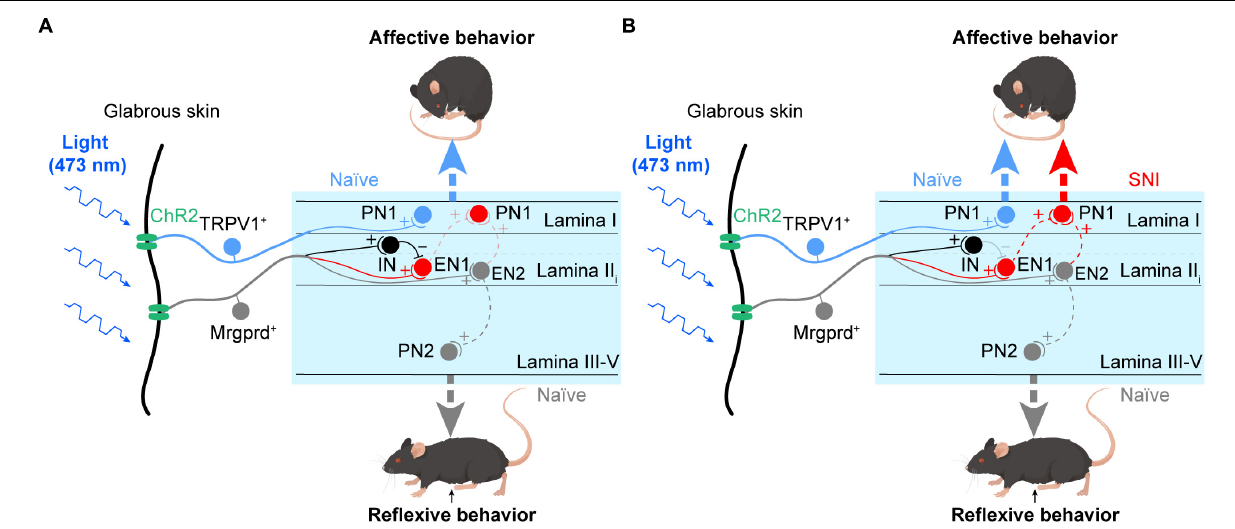
FIGURE 8 | Parallel spinal pathways for transmitting reflexive and affective dimensions of nocifensive behaviors evoked by selective activation of the Mrgprd + and TRPV1 + subsets of nociceptors. (A) Under normal conditions, activation of Mrgprd + afferents elicits reflexive behaviors, which are possibly transmitted through the deep spinal pathway (gray, EN2-PN2). In contrast, activation of TRPV1 + afferents can elicit affective behaviors, which are possibly transmitted through the superficial spinal pathway (blue, TRPV1-PN1). (B) Under neuropathic pain conditions, activation of Mrgprd + afferents can evoke affective behaviors by opening the superficial spinal pathway (red). (PN1: projection neurons in superficial layer, PN2: projection neurons in deeper layer, IN: inhibitory neurons, EN1: excitatory neurons that are gated by IN and receive excitatory inputs from Mrgprd + nociceptors, EN2: excitatory neurons that are excited by Mrgprd + nociceptors). We hypothesize that PN1 receives excitatory inputs from EN1 and EN2. The EN1-PN1 pathway which is “gated” via feed-forward activation of IN and the EN2-PN1 pathway which is “gated” via electric filtering of potassium currents transmit affective behaviors. After nerve injury, disinhibition of EN1 and/or central sensitization of PN1 cause “gate-opening” of superficial spinal pathway, leading to unmasking of affective behaviors evoked by Mrgprd + nociceptors.